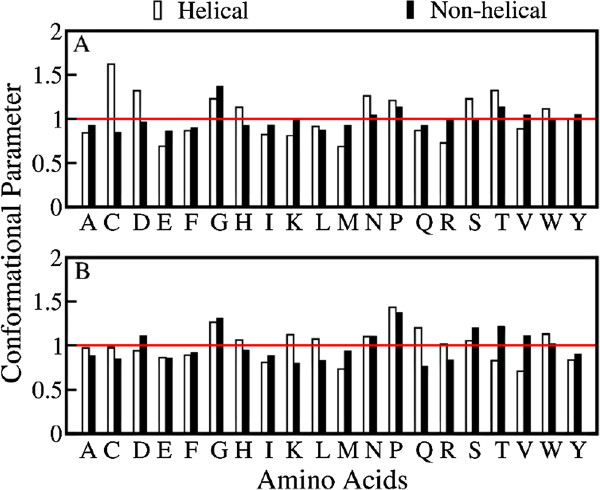
Conformational parameter of amino acids in flanking sequences. Conformational parameter of the amino acids in flanking sequences of (A) N-terminus and (B) C-terminus of helices and their mutated sequences in the non-helical conformations. Conformational parameter here refers to the ration of probability of an amino acid in the flanking sequences to probability of the same amino acid in non-redundant database.